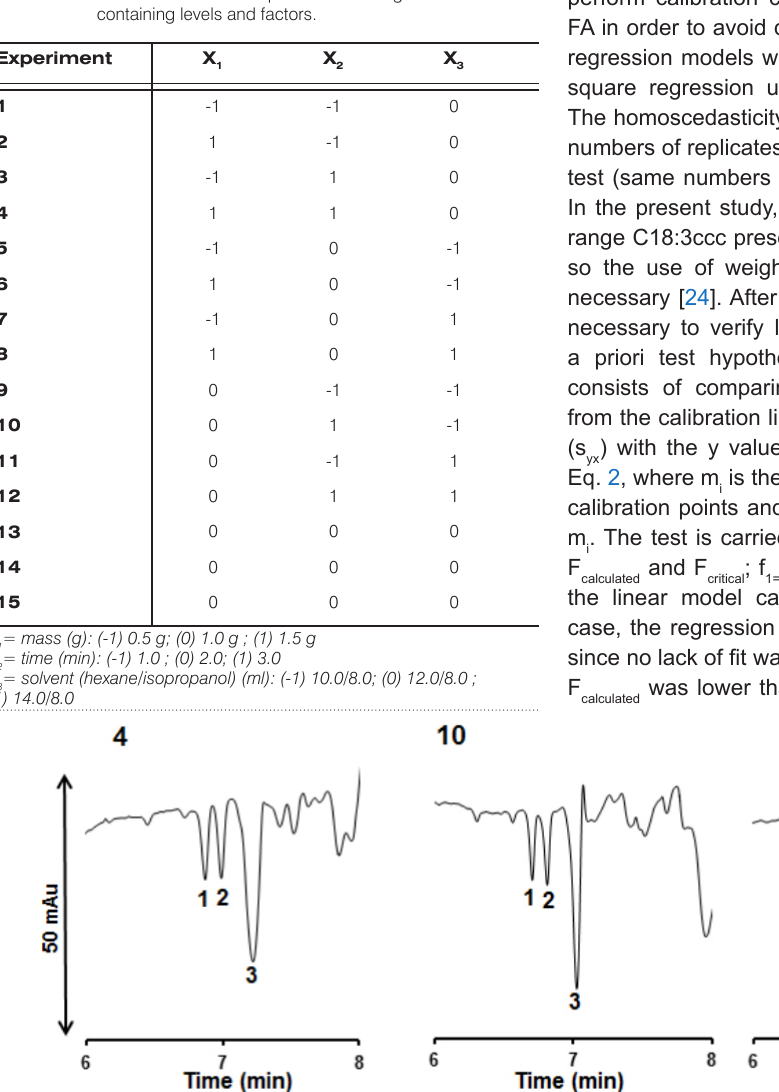
Figure 6. The three best results obtained from analysis of the 3 3 Box Behnken experimental design by Hara & Radin extraction method. Peaks: 1-C16:0, 2-C18:2 and 3-C18:3. Operational conditions: injection 4 s 12.5 mbar, voltage +19 kV, indirect detection at 224 nm and 25°C temperature inside the cartridge, TSH capillary with 48.5 cm long (40 cm effective length) 75 μm I.D and 375 mm